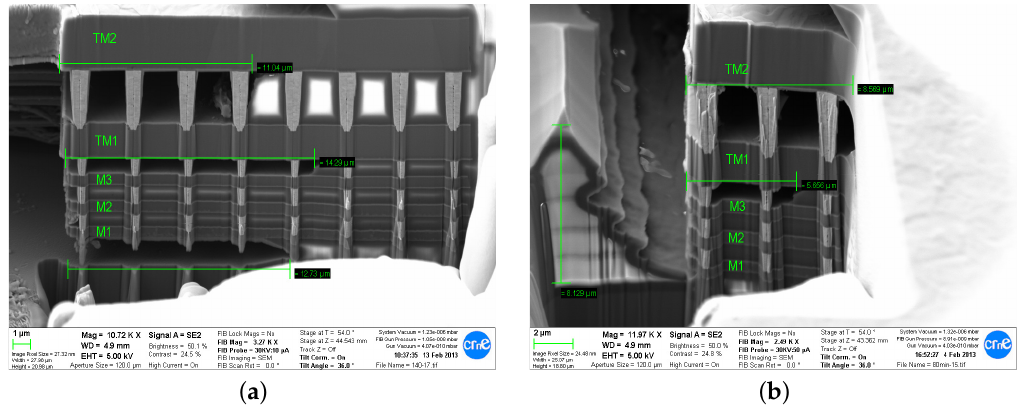
Figure 7. FIB cut of multi-metal guardring after: 140 min etching ( a ); and 80 min etching ( b ). Note